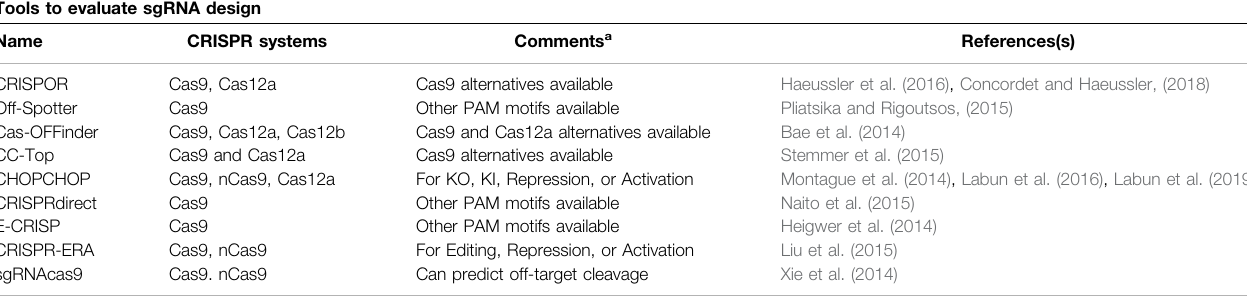
TABLE 3 | Web-Based Tools for sgRNA Design in S.